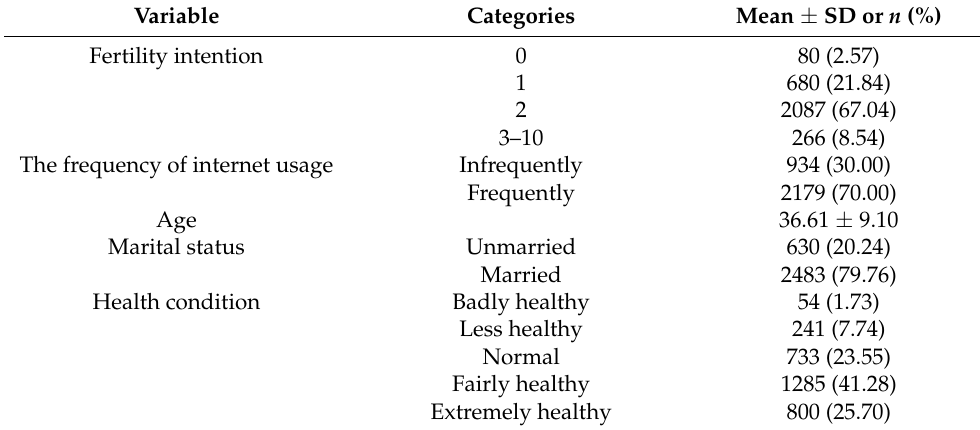
Table 1. Demographic characteristics and outcome variables of the participants ( n =